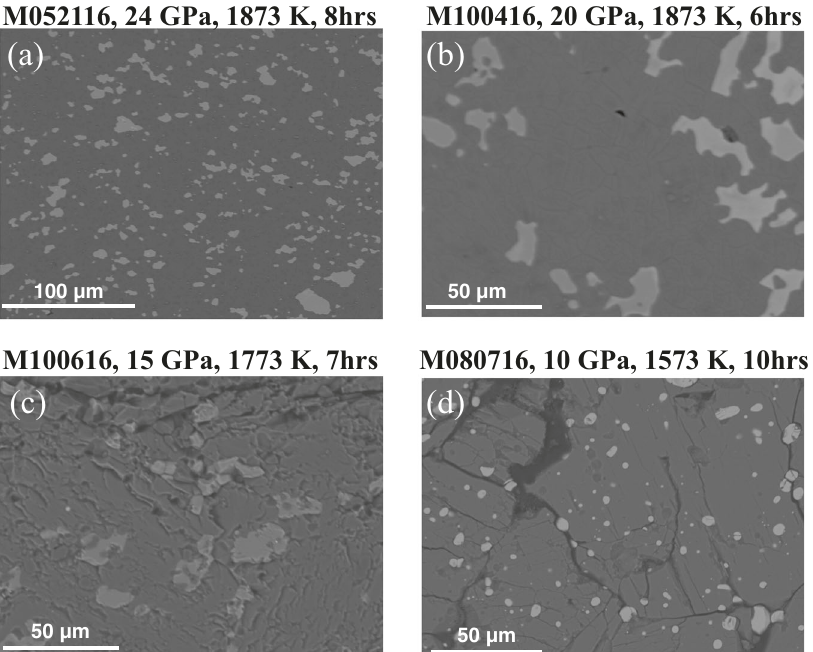
Fig. 1 Back-scattered scanning electron microscope images of recovered experimental phase assemblages forming from 90% MgSiO 3 + 10% Fe 2 O 3 starting mixture after equilibrium at mantle pressure – temperature conditions for 6 – 10 h. Bridgmanite/akimotoite with ~50 mol% Fe 2 O 3 substitution in both Mg and Si sites (bright phases in ( a – c )) coexists with normal mantle minerals such as Fe-poor bridgmanite (dark phases in ( a ) and ( b )) at >20 GPa, or with wadsleyite (gray phase in ( c )) + stishovite (dark phase in ( c )) at 15 GPa, while Fe 2 O 3 (bright phase in ( d )) was stabilized as a separate phase with Fe-depleted clinopyroxene (dark phase in ( d )) at 10